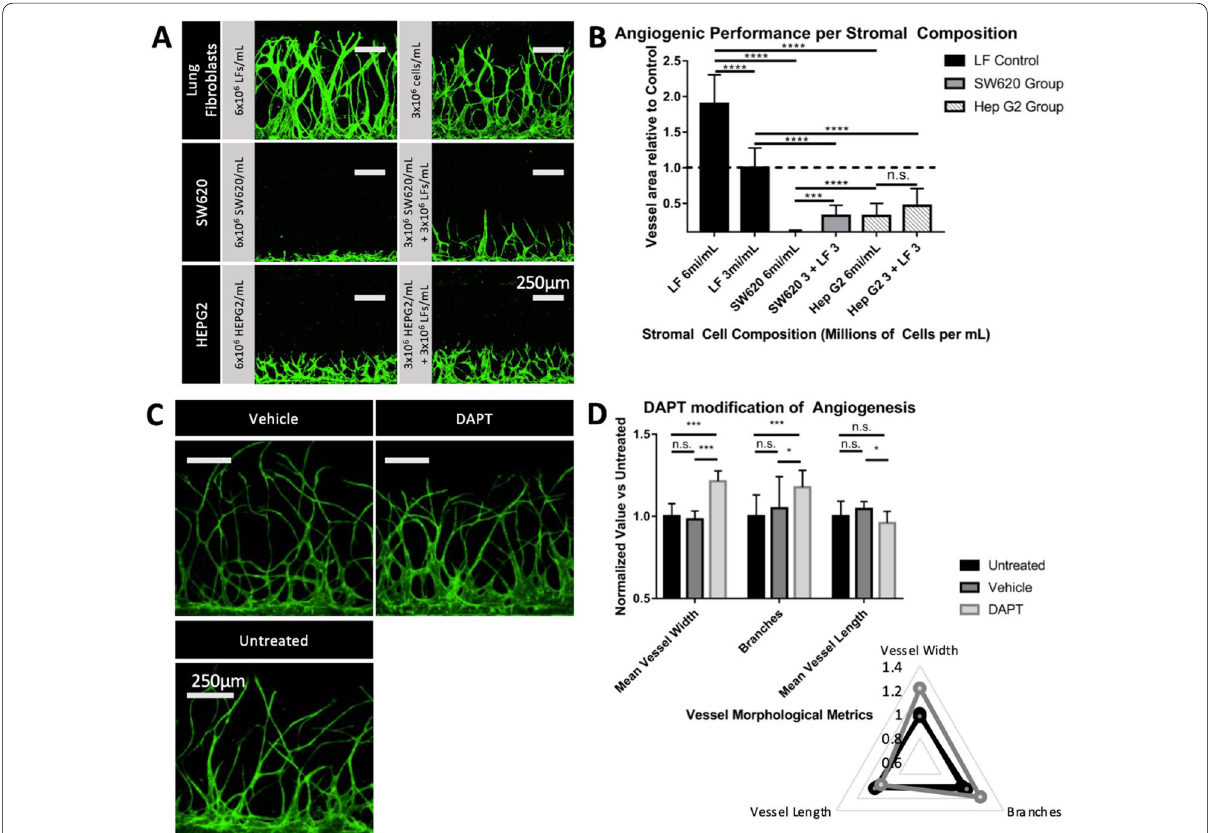
Fig. 4 Angiogenic assays conducted testing for stromal component mediated and DAPT induced notch inhibition mediated morphological differences. A Confocal images of angiogenic sprouting induced by stromal cell component groups comprising of normal human lung fibroblasts at 6 10 6 cells mL − 1 and 3 ×